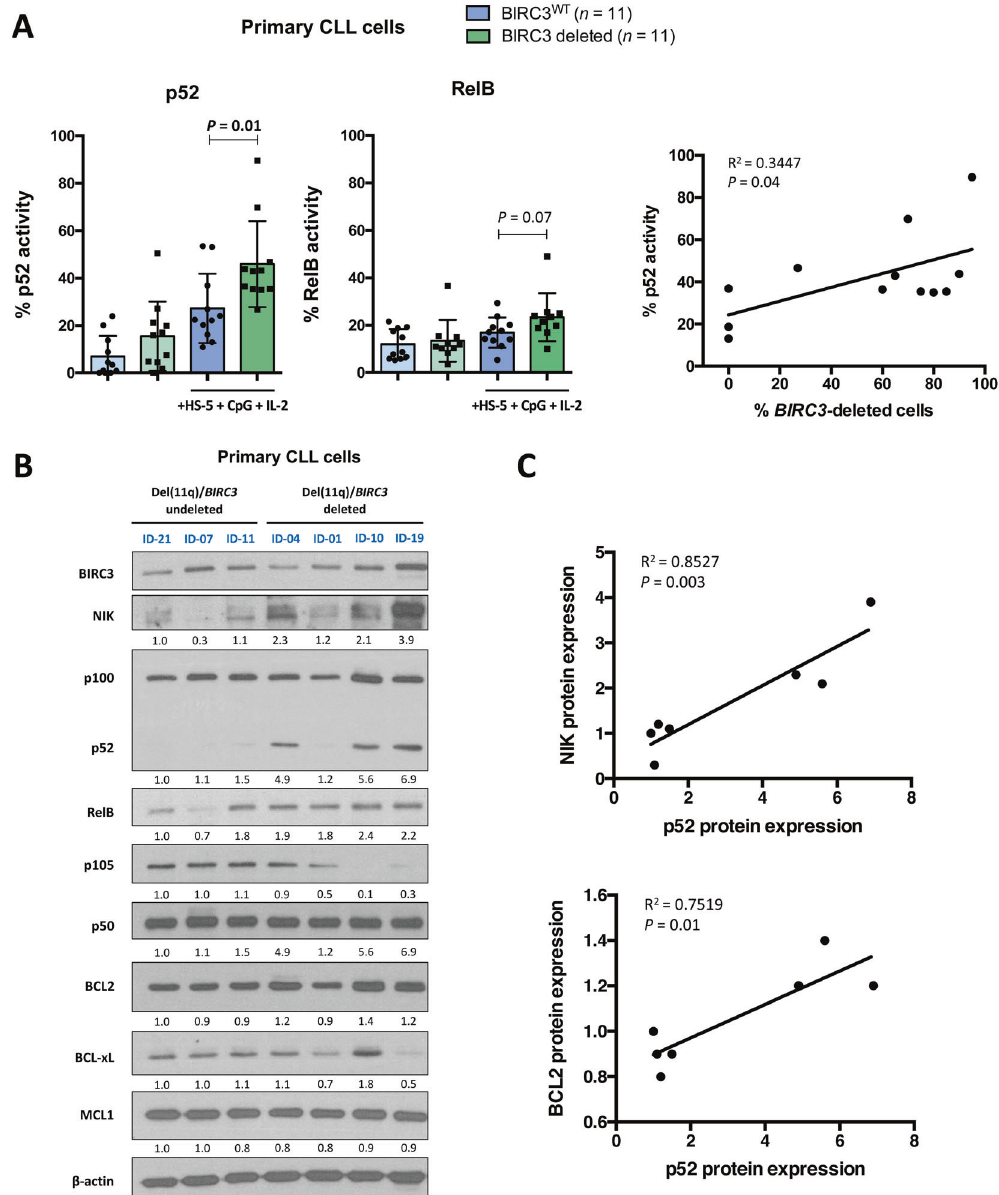
Fig. 3 Effects of BIRC3 loss in NF- κ B activity and BCL2 levels of del(11q) primary CLL cells. A Left panel: ELISA measurement of relative NF- κ B2 p52 and RelB DNA-binding activity in cell lysates from BIRC3 WT (including both non-del(11q) or del(11q) without BIRC3 loss) ( n = 11) and BIRC3 -deleted ( n = 11) primary CLL samples stimulated to proliferate with HS-5 cells, 1.5 μ g/mL CpG and 50 ng/mL IL-2 or without stimulation. Proteins were extracted 24 h after co-culture. Data are represented as the mean ± SD. Right panel: correlation between the percentage of BIRC3 -deleted cells in del(11q) patients (by integrating FISH and NGS data) and relative p52 activity taken from DNA-binding activity assays. Full details about cytogenetics and mutational status of the primary CLL cells used in the experiments are summarized in Supplementary Table S2. B Whole-cell lysates from stimulated CLL primary samples harboring del(11q) not involving BIRC3 (del(11q)/ BIRC3 -undeleted) (ID-21, ID-07, ID-11) and del(11q) involving BIRC3 (del(11q)/ BIRC3 deleted) (ID-04, ID-01, ID-10, ID-19) primary CLL samples were analyzed by immunoblotting for BIRC3 , NIK, NF- κ B2 (p100/p52), RelB, NF- κ B1 (p105/p50), BCL2, BCL-xL and MCL1 proteins. β -actin was used as loading control. C Correlation between p52 protein levels and NIK (left panel) or BCL2 (right panel) protein levels from the patients analyzed by